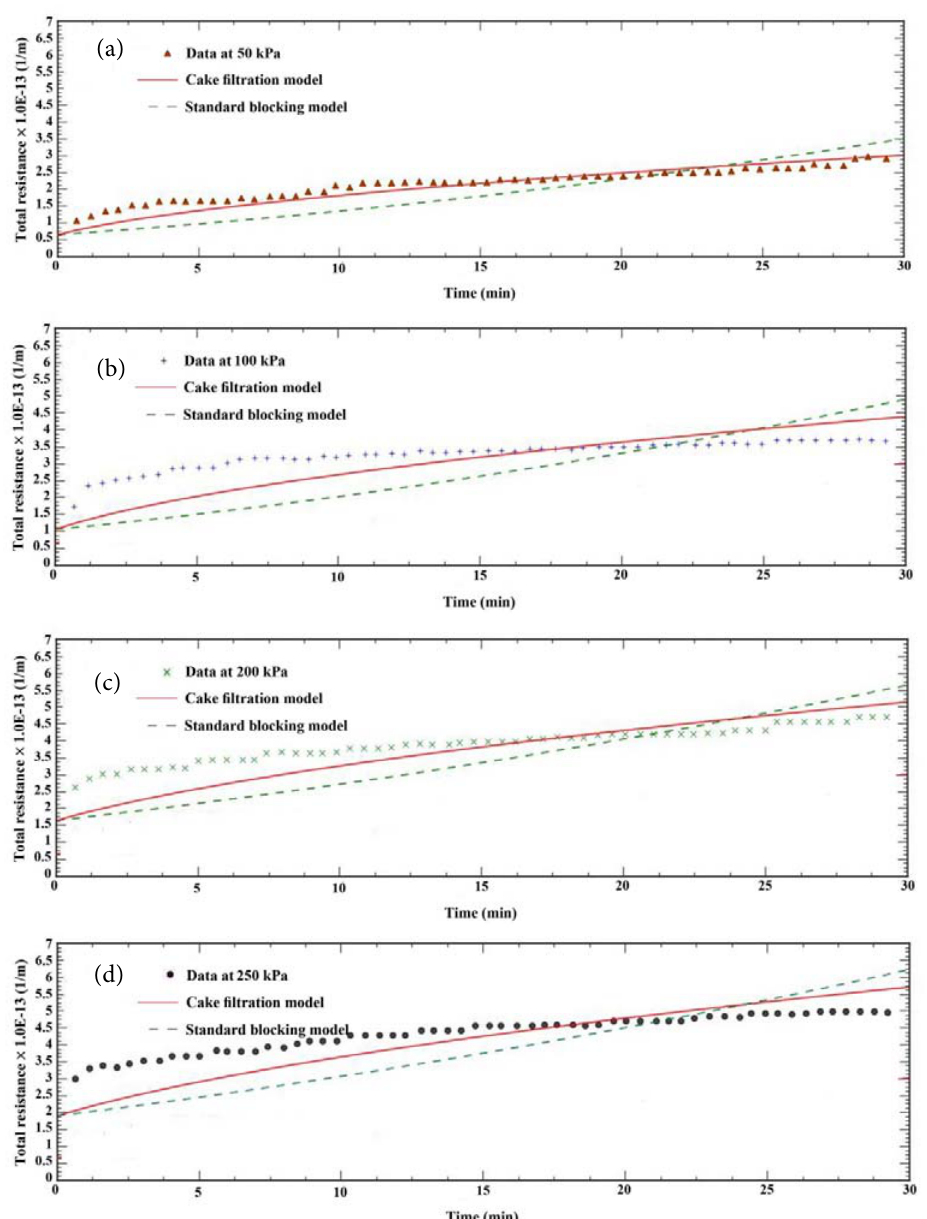
Fig. 2: Resistance vs. time data compared to the cake formation model and standard blocking model: (a) 50 kPa, (b) 100 kPa, (c) 200 kPa and (d) 250